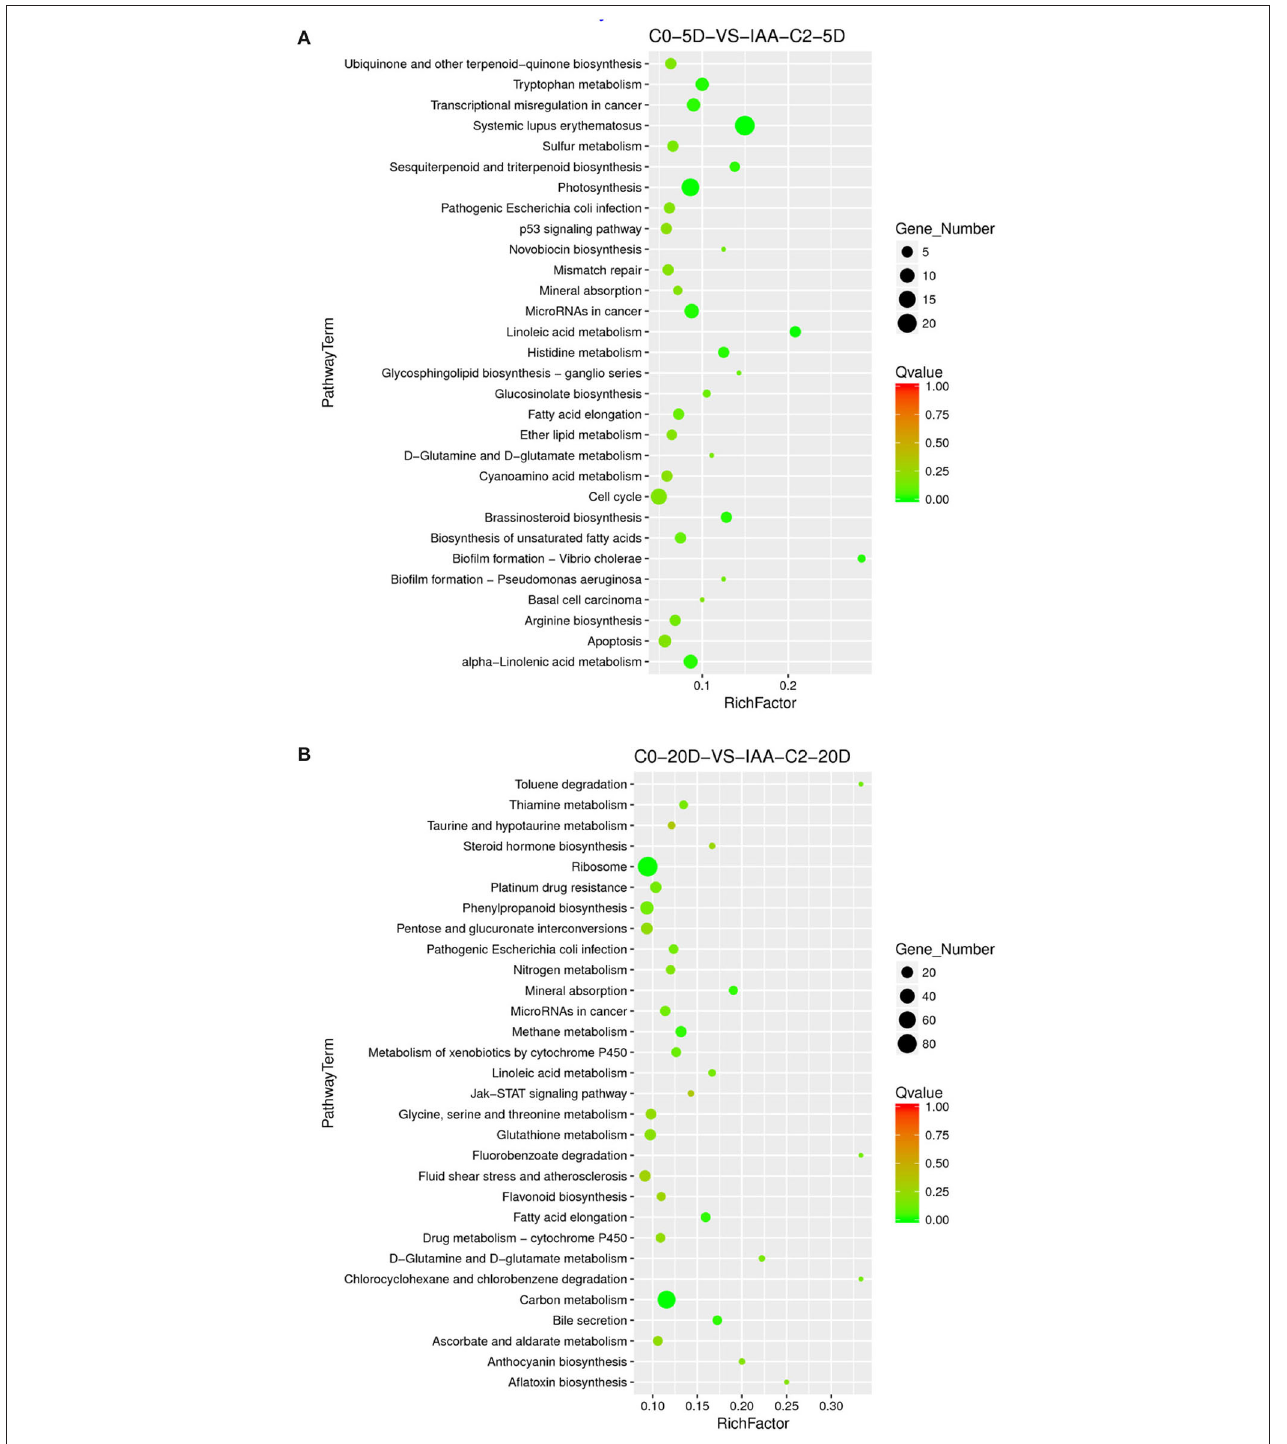
FIGURE 4 | The KEGG enrichment of DEGs in comparison groups under the IAA induction effect. (A) Pathways enriched in C0-5D vs. IAA-C2-5D; (B) Pathways enriched in C0-20D vs. IAA-C2-20D. IAA, indole acetic acid; C0, 0mg L − 1 ; C2, 0.05mg L − 1 ; 5D, 5 days’ treatment; 20D, 20 days’ treatment.